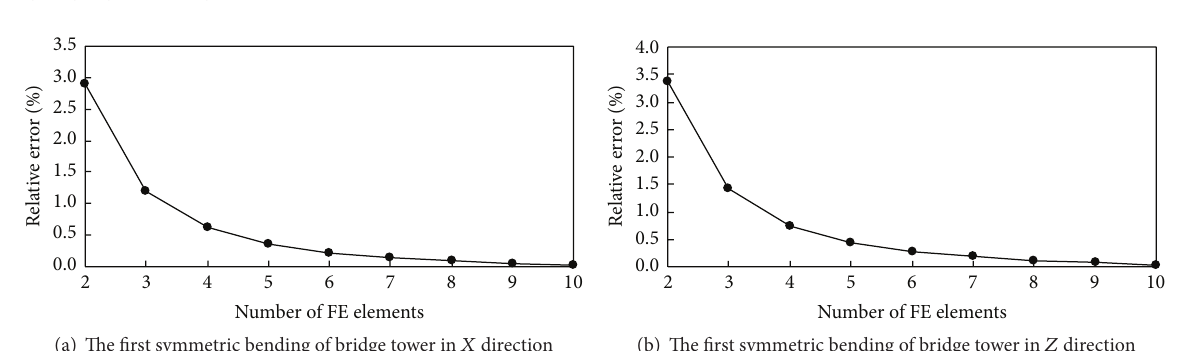
Figure 6: Relative errors of model frequencies with regard to various numbers of FE elements of bridge